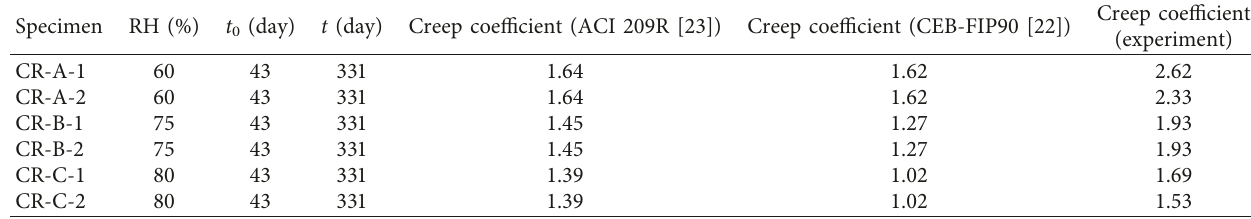
Figure 10: Creep coefficients compared with the analytical model: (a) specimens CR-A-1 and CR-A-2; (b) specimens CR-B-1 and CR-B-2; (c) specimens CR-C-1 and Table 5: Parameters and calculated results for the predicted creep coefficients.